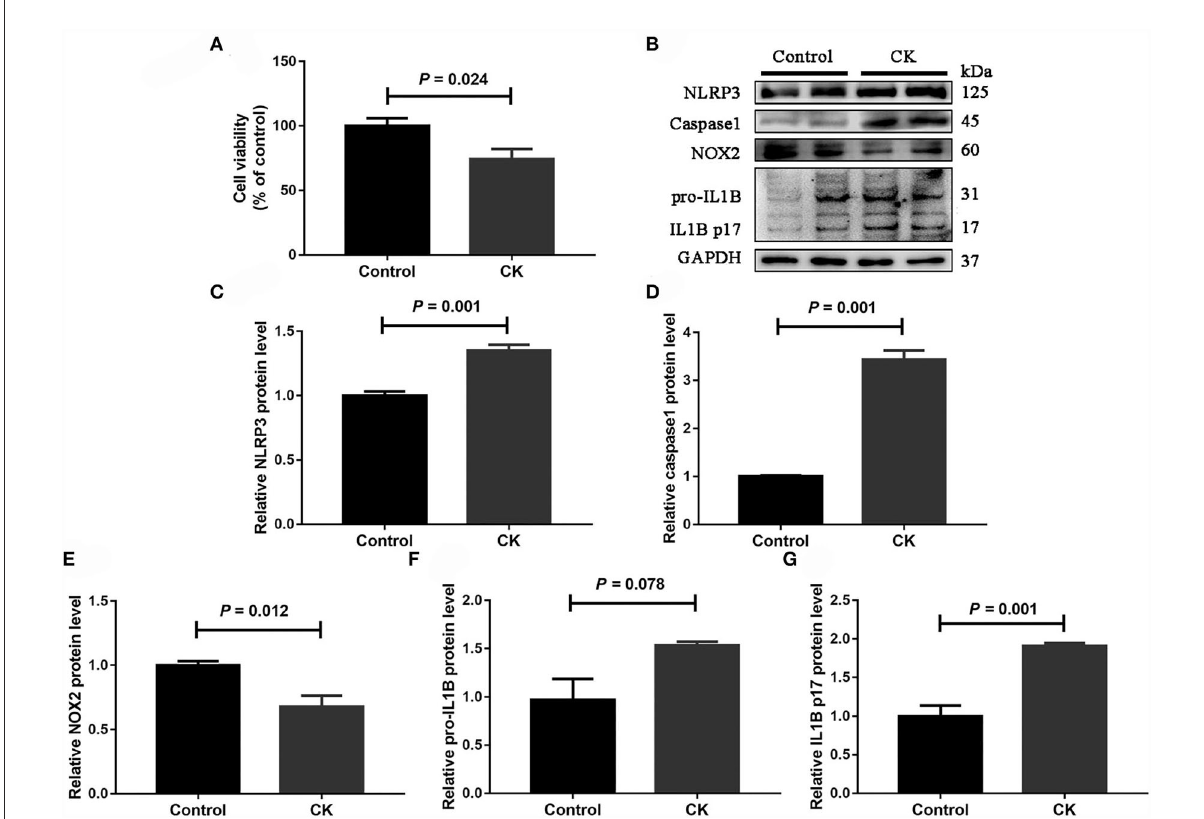
FIGURE4 Abundance of molecules involved in the NLRP3 inflammasome pathway in CD14 + monocytes from healthy cows ( n = 12), and clinically ketotic cows (CK, n = 12). (A) Monocyte cell viability. (B) Western blot analysis of NLRP3, caspase 1, NOX2, pro-IL1B and IL1B p17. (C) Protein abundance of NLRP3. (D) Protein abundance of caspase 1. (E) Protein abundance of NOX2. (F) Protein abundance of pro-IL1B. (G) Protein abundance of IL1B p17. Data were analyzed with paired t -tests and reported as means ± SEM of three independent